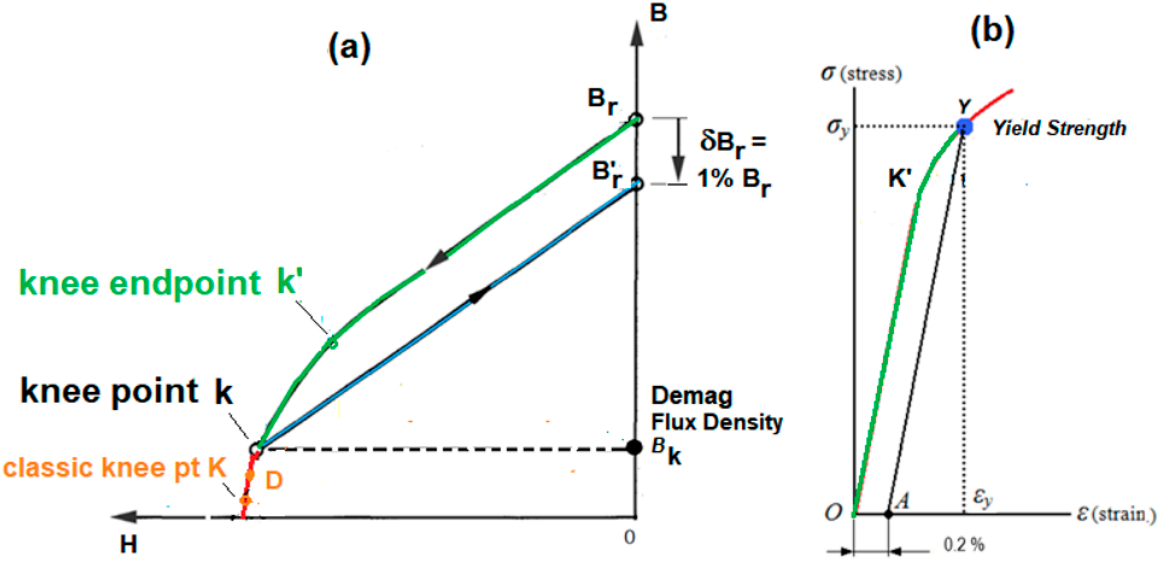
Figure 4. ( a ) Knee point k defined by the 1% offset method prevents the degeneration of a magnet. ( b ) Yield strength defined by the 0.2% offset method prevents the metal from going plastic.